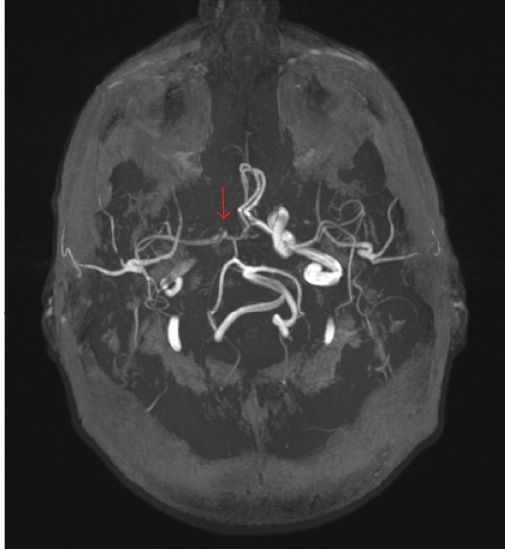
Figure 5: Obvious low flow in right distal ICA.